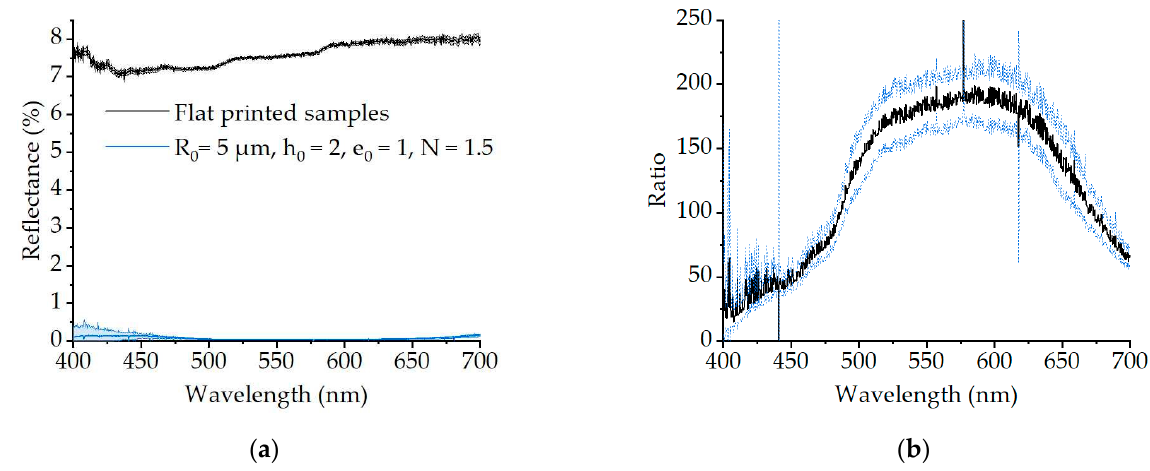
Figure 4. Effect of the printed geometries on the reflectance spectra. ( a ) Average reflectance spectra of the flat printed samples and of the optimized microlens array sample, with respective error of 1𝜎 ; ( b ) Ratio between the flat and optimized structure’s reflectance with blue lines showing error of 1𝜎 .